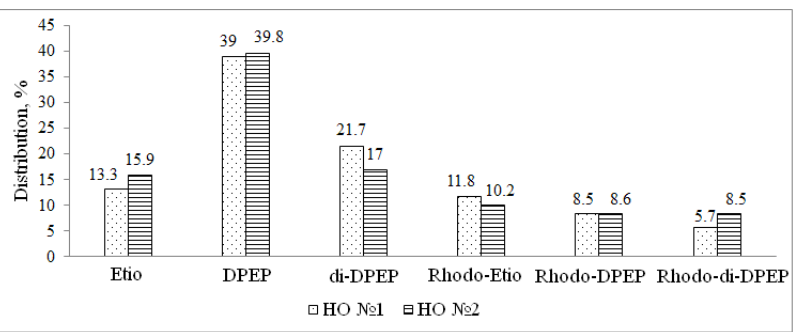
Figure 9. Relative abundance of various types of vanadyl porphyrins in pVP from the resins of HO nos. 1 and 2.